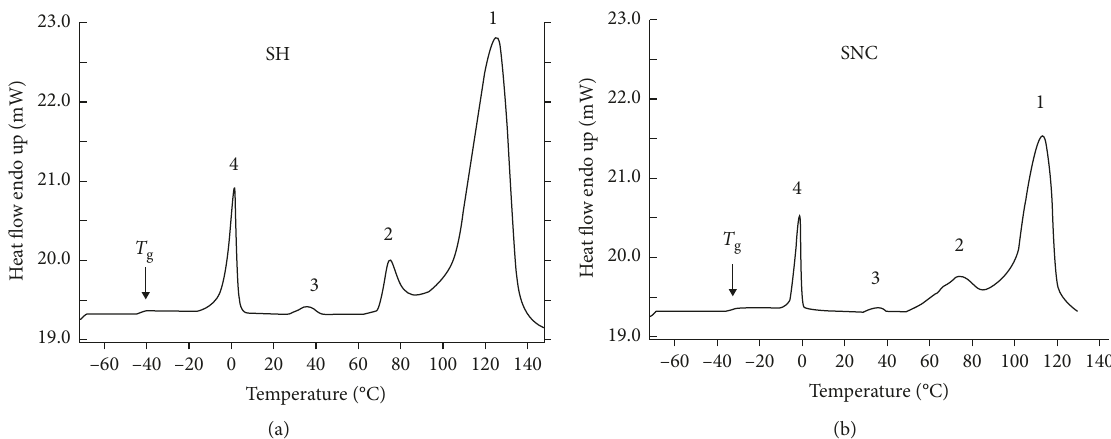
Figure 3: Thermal analysis of the plant tissue of the SH and SNC endosperm. Peak 1: evaporation of water; peak 2: fusion of starch; peak 3: lipid fusion; peak 4: fusion of frozen water. T g : glass transition. Table 4: Thermal transitions of the main components present in cotyledons of SH and SNC. Sample